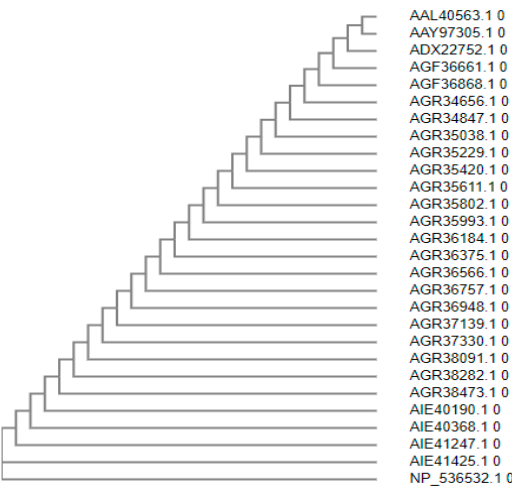
Figure 1. Phylogenetic tree of